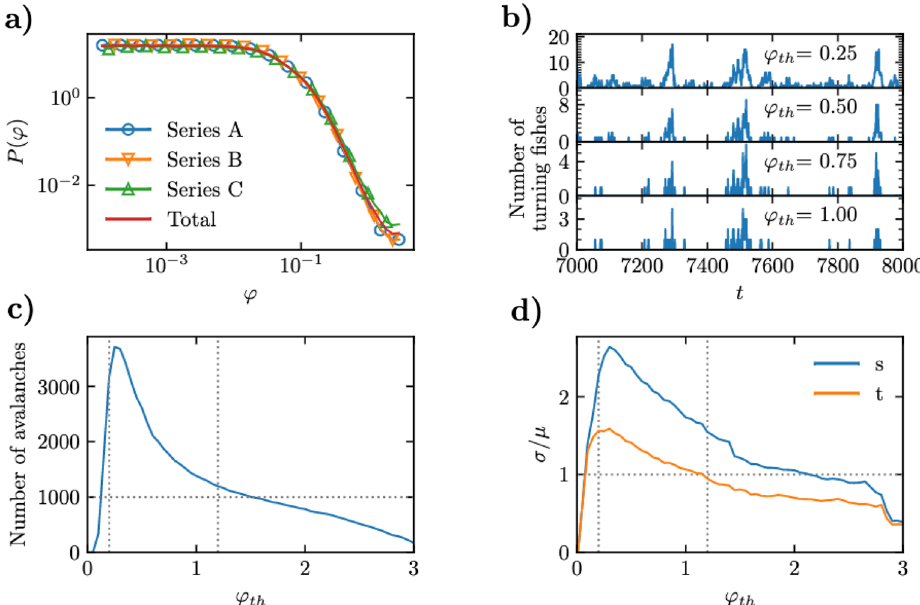
Figure 1. ( a ) Probability density of turning angles ϕ of individual fish. ( b ) Number of fish turning an angle larger than ϕ th in a sequence of 1000 frames in data series A, for different values of the turning threshold. ( c ) Number of avalanches observed as a function of the turning threshold. ( d ) Relative fluctuations of the avalanche size ( s ) and duration ( t ) distributions as a function of the turning threshold. Vertical lines in ( c ) and ( d ) represent the turning threshold interval [0.2,